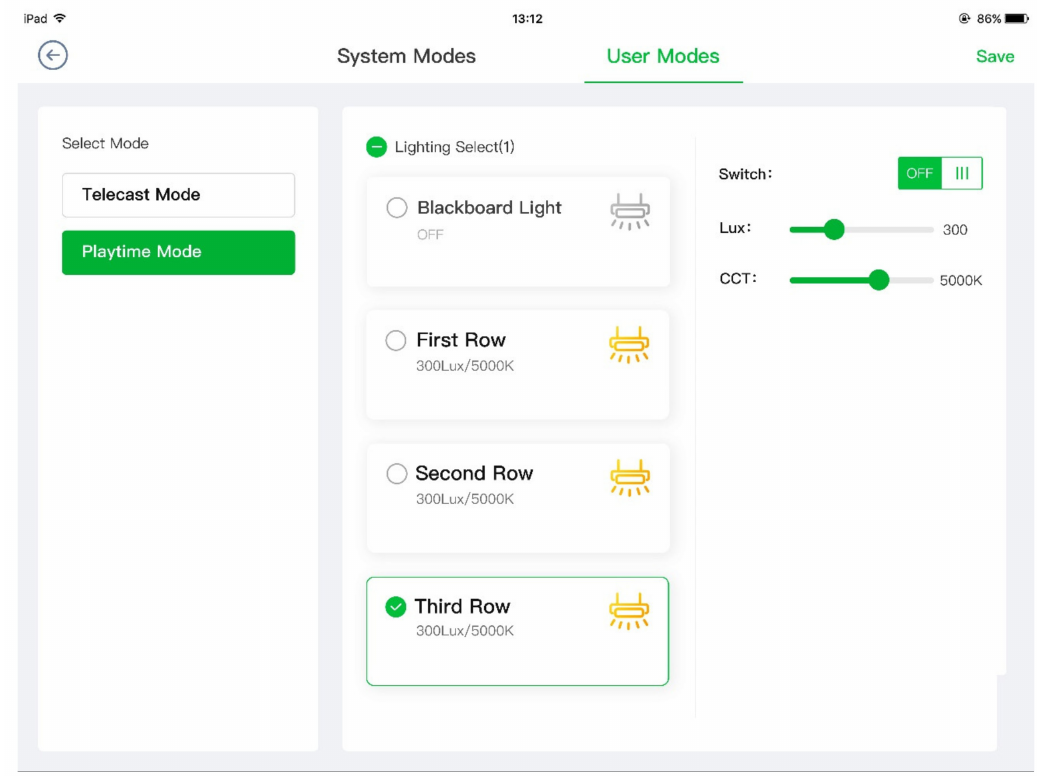
Figure 17. Tablet user interface (UI) of user-defined